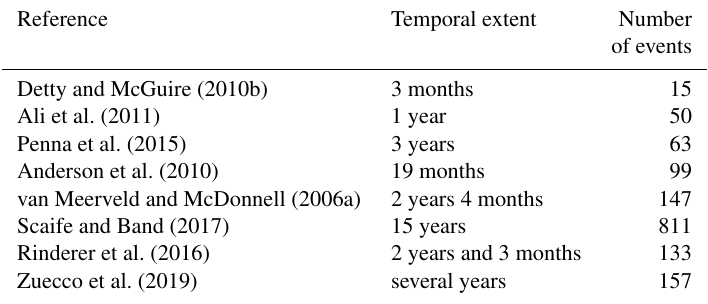
Table 5. Selection of studies and the number of events analysed.